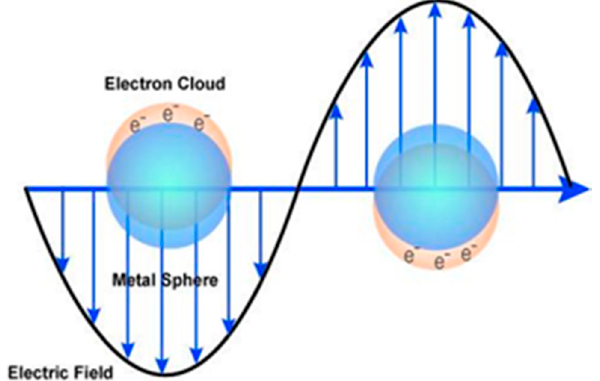
Figure 11. Surface plasmon resonance while the free electrons in the metal nanoparticles (NPs) derive into oscillation because of a robust interaction with incident light at a certain wavelength [102].